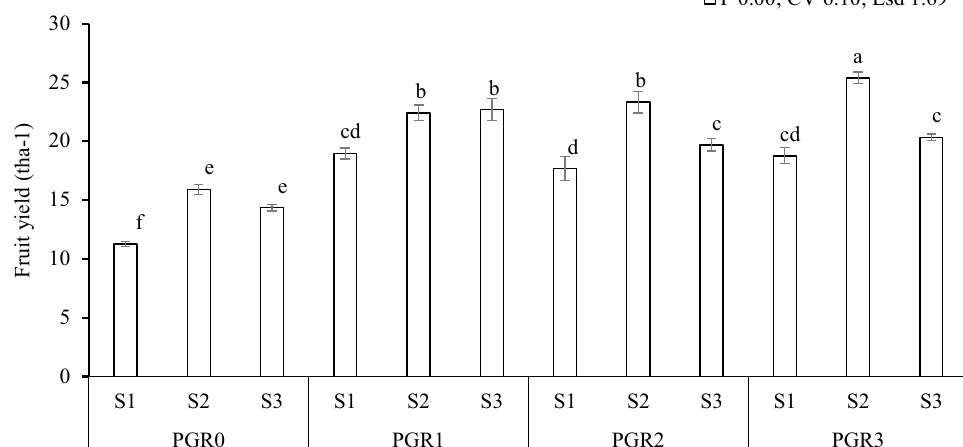
Fig. 2 Effect of plant growth regulators at various application stages on fruit yield (tha − 1 ) in bitter gourd. Abbreviations are as follows: PGR 0 : 0, PGR 1 : 100 mgL 2 : 4-leaf stage and S 3 : flower bud stage. Different letters in the same column indicate significant differences between treatments ( p < 0.05). Vertical bars indicate standard errors